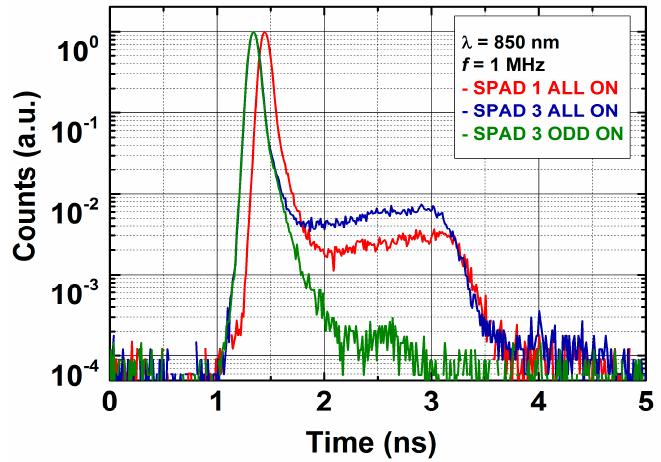
Figure 5. SPAD 1 (red line) and SPAD 3 (blue and green lines) responses to a laser pulse. By comparing SPAD 1 and SPAD 3 curves, it can be observed that crosstalk counts in SPAD 3 are almost double with respect to SPAD 1, as it receives contributions from both SPAD 2 and 4, whereas SPAD 1 only from SPAD 2. Optical crosstalk contribution is negligible on SPAD 3 when adjacent SPADs are turned OFF (green curve). Each curve is normalized to its main peak.